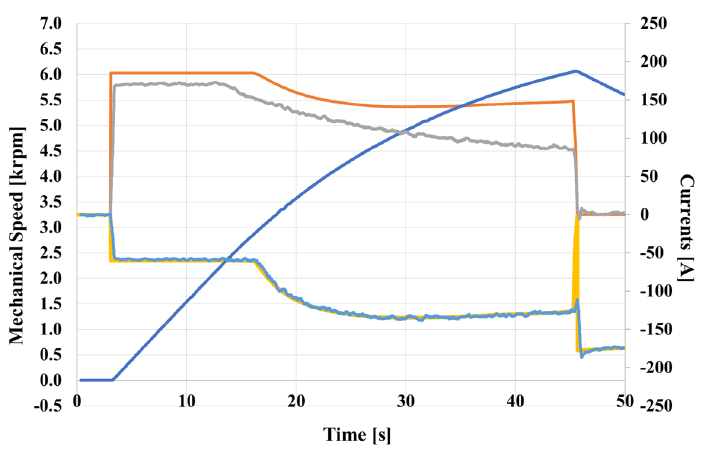
Figure 14. Experimental results of outer voltage method of [17] with proposed FW control. Speed profile and i sd , i sq